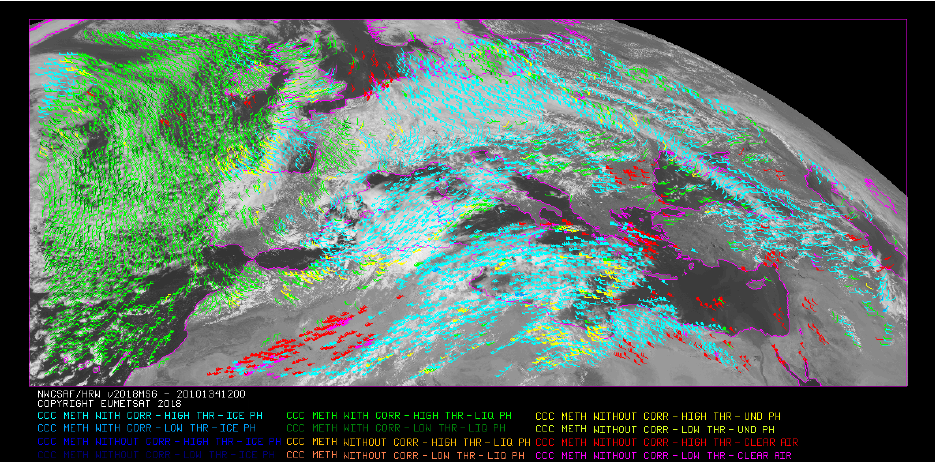
Figure 9. AMV height assignment (CCC method with or without microphysics correction, using the high or low CCC method calculation threshold), and AMV phase (ice cloud AMV, liquid cloud AMV, mixed/undefined cloud AMV, clear air AMV), in a NWC/GEO-HRW example for the European and Mediterranean region, with the default conditions for MSG satellites (14 May 2010, 12:00 UTC, MSG·2 satellite).